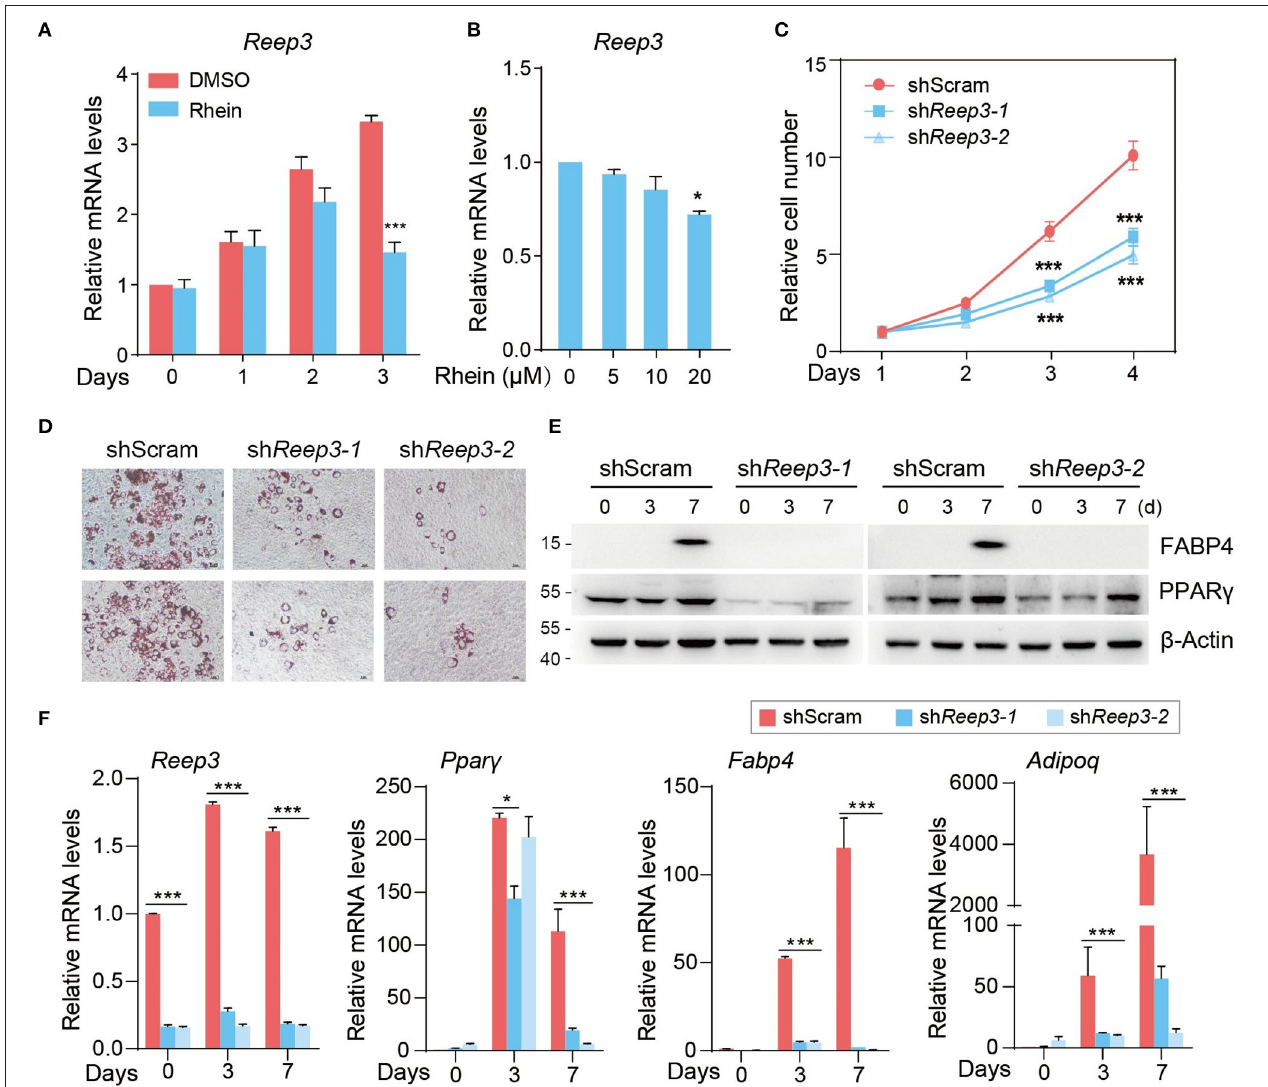
FIGURE 5 | Receptor expressing-enhancing protein 3 (REEP3) is essential for efficient adipocyte differentiation. (A) Relative mRNA levels of Reep3 under DMSO or rhein treatment during the MCE stage. Error bars, mean ± SEM; n = 4 biological replicates; *** p < 0.001. (B) Effect of rhein treatments with various concentrations on mRNA levels of Reep3 . Error bars, mean ± SEM; n = 4 biological replicates; * p < 0.05. (C) The proliferation rate of shScram and sh Reep3 3 cells. Error bars, mean ± SEM; n = 3 biological replicates; *** p < 0.01. (D) The adipogenic phenotypes of sh Reep3 and shScram cells. Lipid accumulation was assessed by using Oil Red O staining; scale bars, 5 µ m. (E) Western blotting of fatty acid-binding protein 4 (FABP4) and peroxisome proliferator-activated receptor γ (PPAR γ ) in sh Reep3 and shScram cells. (F) Relative mRNA levels of Reep3 , Ppar γ , Fabp4 , and adiponectin ( Adipoq ) in knockdown (sh Reep3-1 and sh Reep3-2 ) and control (shScram) cells. Error bars, mean ± SEM; n = 4 biological replicates; * p < 0.05, *** p <